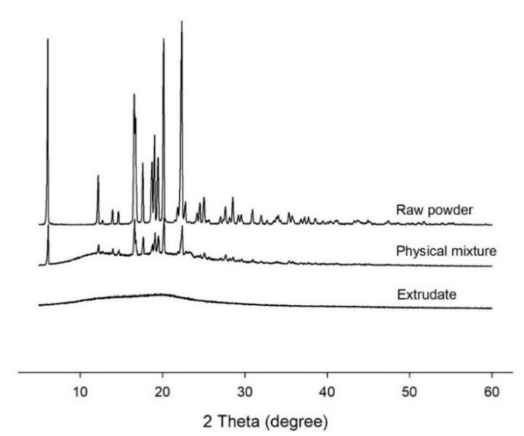
Figure 4. X-ray di ff ractogram of materials of raw active pharmaceutical ingredients (API) powder, physical mixture, and